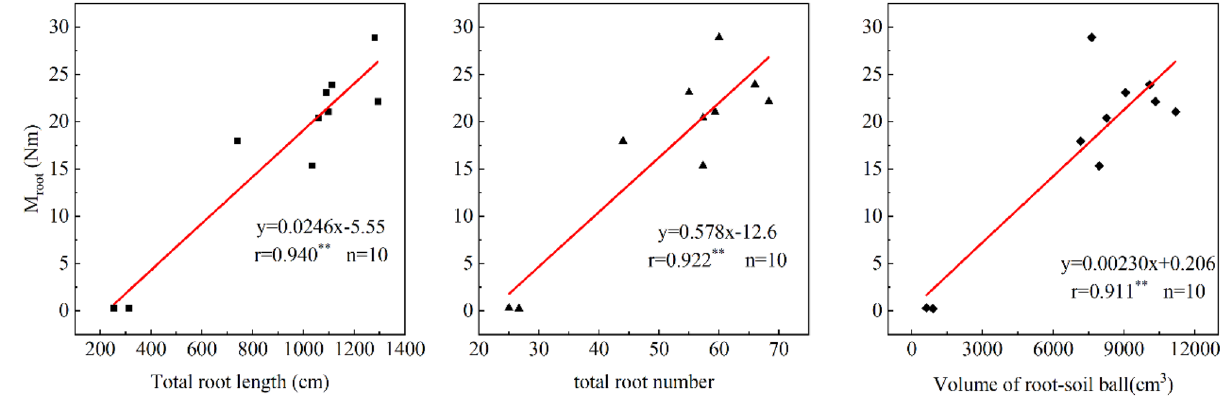
Figure 5. The linear relationship between root morphological traits and root failure moment. **Statistically significant at 0.01 probability